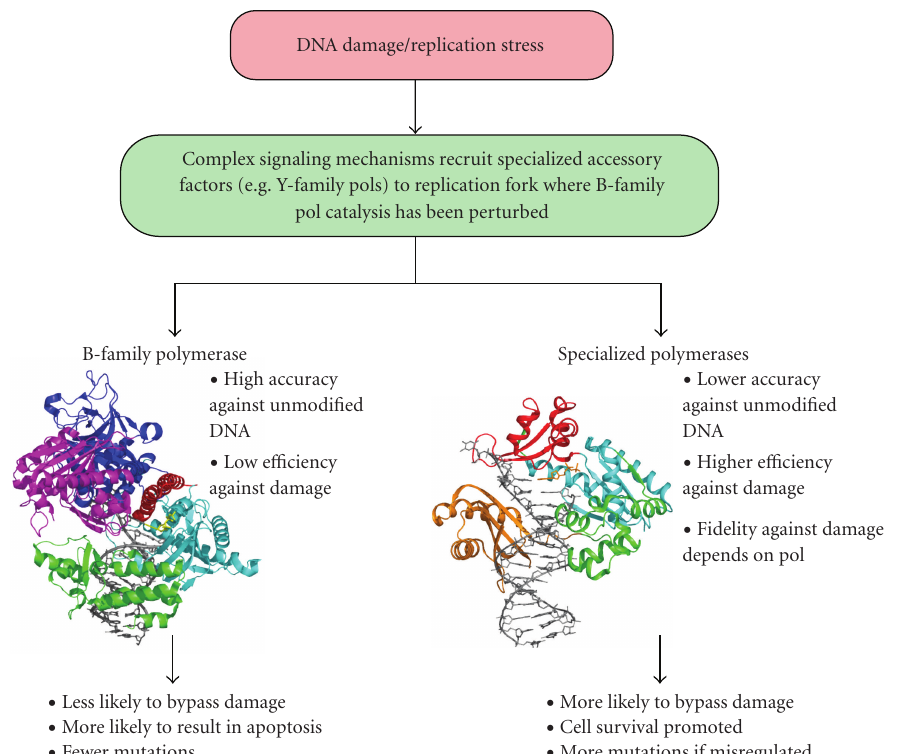
Figure 2: Schematic overview of DNA damage tolerance and two families of DNA polymerases that are partitioned at the replication fork during translesion DNA synthesis. Genotoxic insults can lead to damage that stalls or slows the replication fork. Signaling through the ATM and ATR kinases leads to the recruitment of nonessential “bypass” polymerases. The Y-family pols appear to be the primary means of synthesizing past DNA lesions at stalled or collapsed replication forks but misregulation of these enzymes can lead to events that promote mutagenesis and ultimately tumorigenesis. The exquisite regulation of Y-family DNA polymerases is vital to cellular survival in the face of DNA damage and in the prevention excessive mutagenesis. Two DNA polymerase structures are shown, that of the catalytic subunit of the B-family member yeast pol δ in ternary complex with 12/16-mer DNA (gray) and an incoming dCTP (yellow) (pdb id code 3IAY; [42]). The Y-family polymerase Dpo4 from S. solfataricus is also shown in ternary complex with 13/18-mer DNA (gray) and an incoming ddATP (pdb id code 1JX4; [43]). Both enzymes possess the core the palm (cyan), finger (red), and thumb (green) domains. Pol δ also has a 3 (cid:2) to 5 (cid:2) exonuclease domain (magenta), as well as the N-terminal domain (dark blue). The little finger domain (orange) is unique to the